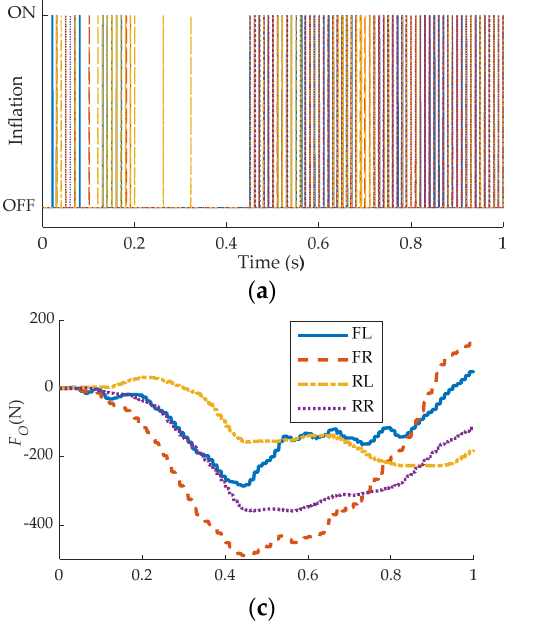
Figure 7. Outsourced mode activation state. ( a ) Solenoid valve actions during inflation in OMA. ( b ) Solenoid valve actions during deflation in OMA. ( c ) Best suspension forces generated by OMA.